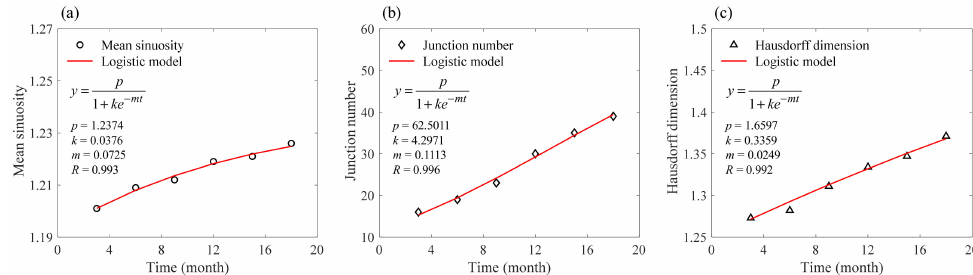
Figure 15. Variation of the tidal channel ( a ) mean sinuosity, ( b ) junction number, and ( c ) Hausdorff